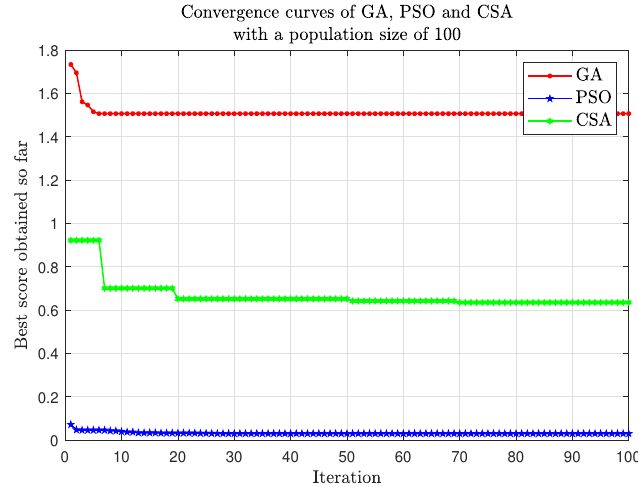
Figure 6. Convergence curves of GA, PSO and CSA with population size 100.